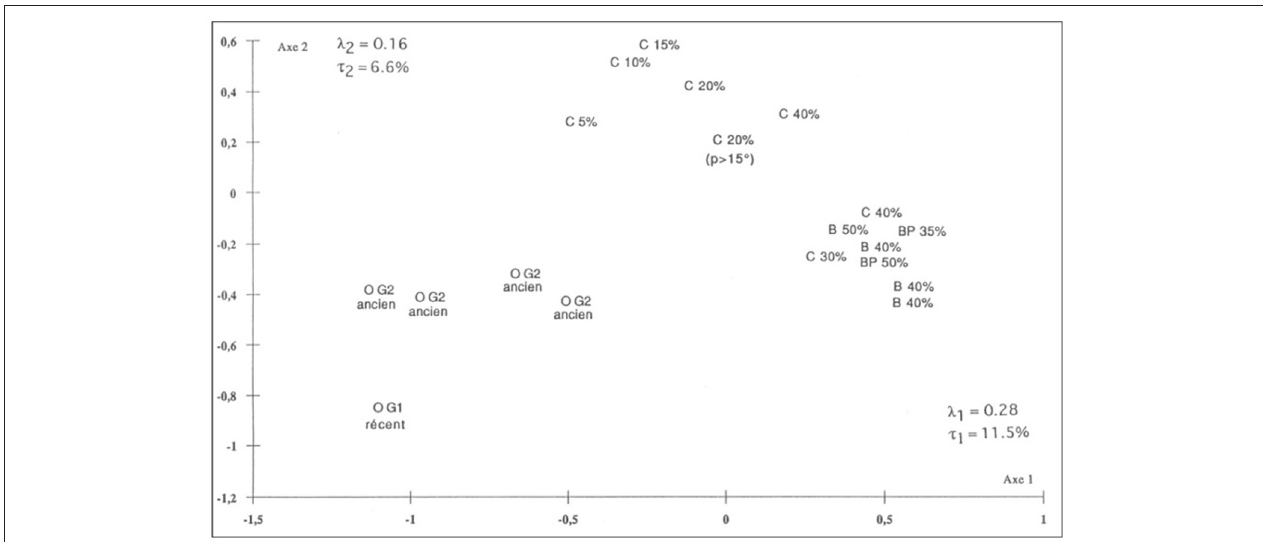
FIGURE 7 | Multi-Dimensional Scaling (MDS) Plot to show the degrees of similarity and difference in the edaphic parameters recorded at each of 20 survey stations within NIXO 45 together with the fascies recorded at each station. (http://unesdoc.unesco.org/images/0014/001495/149556f.pdf, volume 1 Figure